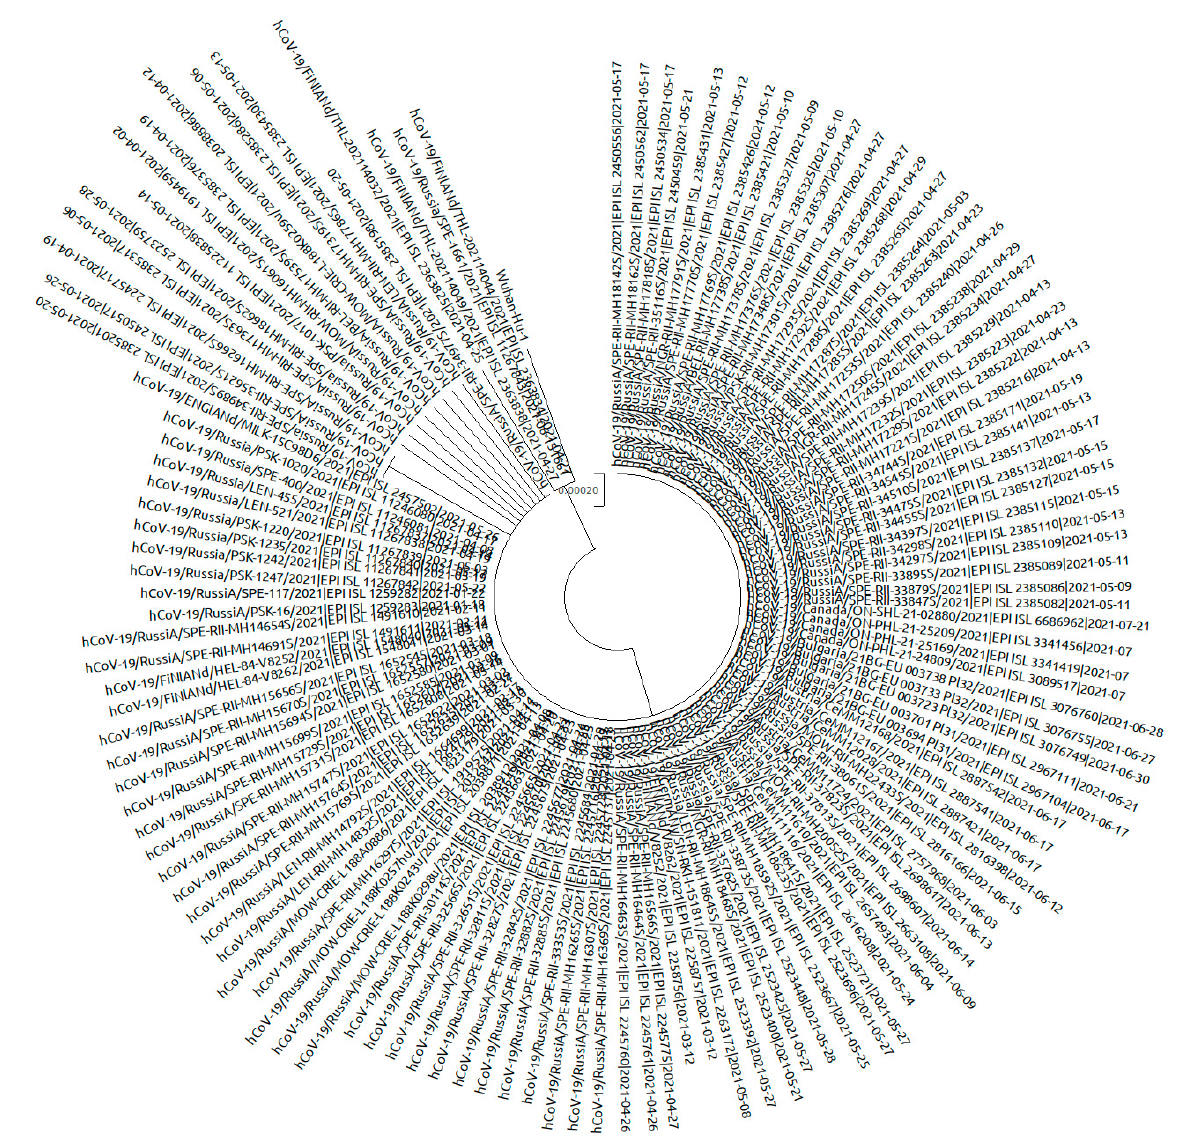
Figure 10. Phylogenetic tree of AT.1 SARS-CoV-2 variants based on S gene sequence alignment. Sequences (127) from Russia and Europe were included in the analysis. The TN92 substitution model was chosen as optimal. Wuhan-Hu-1 sequence used as outgroup (GenBank: NC_045512).